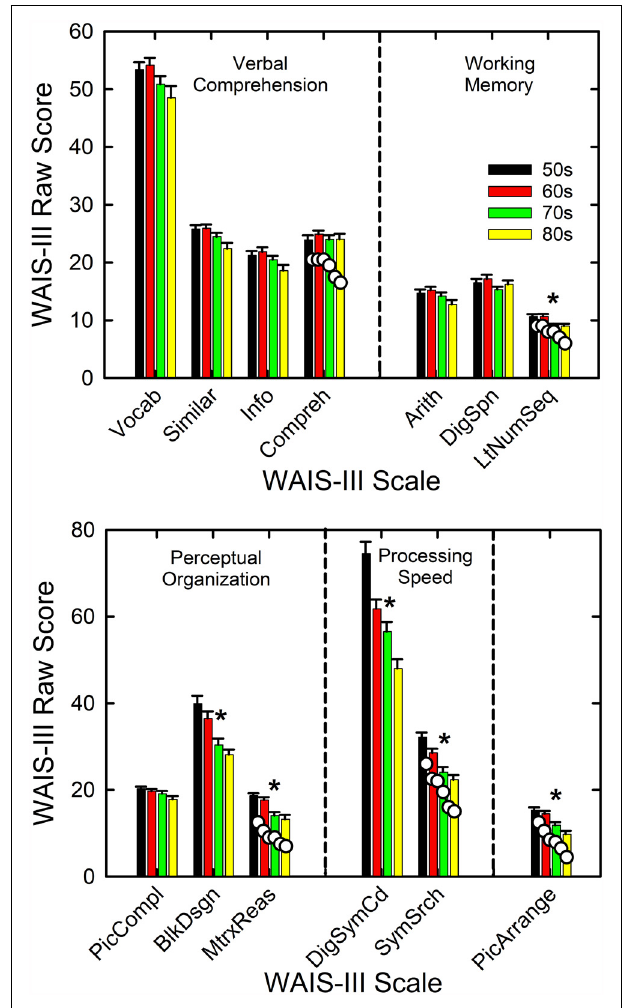
FIGURE 4 | Means and standard errors on the WAIS-III shown by age decade. Measures are partitioned into groups (vertical dashed lines) according to the type of cognitive process. The asterisks mark those measures for which a significant effect of age decade was observed. The white circles shown for the right-most measure in each panel provide example comparisons to normative values from Ardila (2007) for those scales. WAIS-III scales are: Vocab = vocabulary; Similar = similarities; Info = information; Compreh = comprehension; Arith = arithmetic; DigSpn = digit span; LtNumSeq = letter-number sequence; PicCompl = picture completion; BlkDsgn = block design; MtrxReas = matrix reasoning; DigSymCd = digit-symbol coding; SymSrch = symbol search; and PicArrange = picture